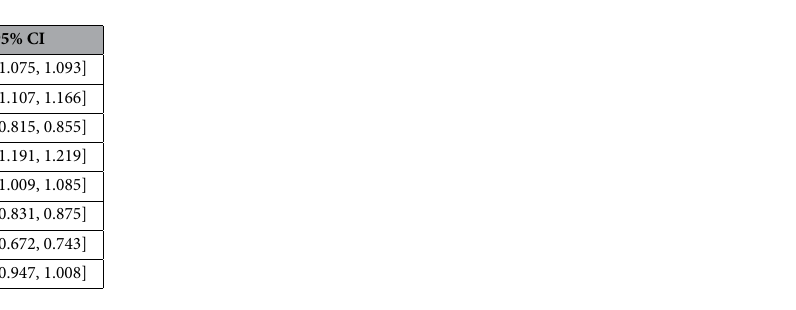
Table 2. The basic reproduction number, R 0 , of COVID-19 for Nepal and its seven provinces. The third column shows the 95% confidence interval of the estimated values of R 0